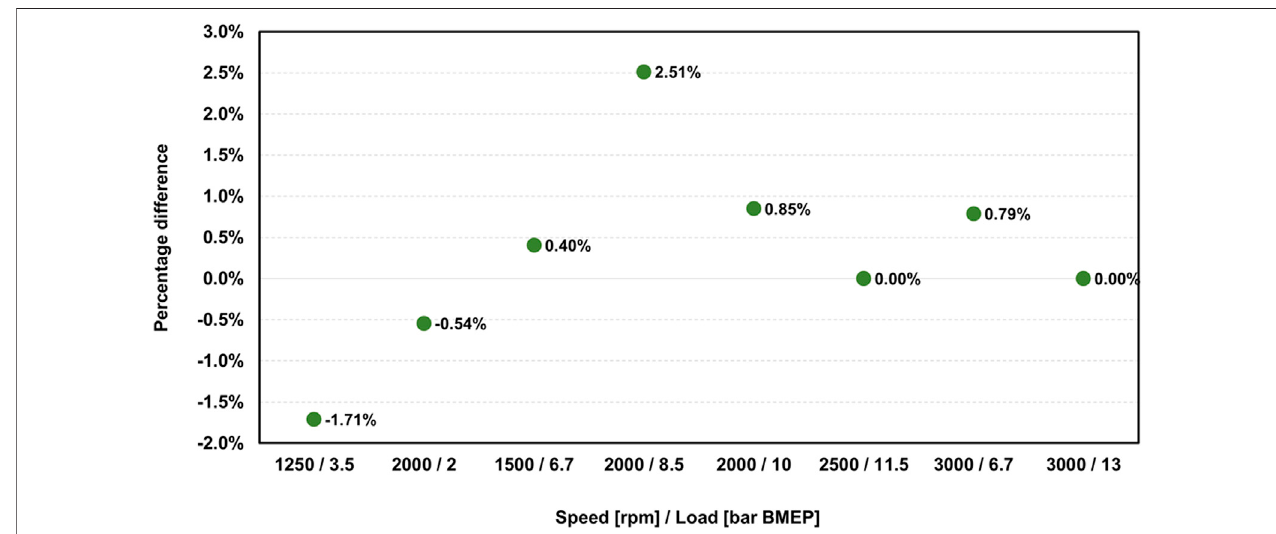
FIGURE 7 | BSFC Percentage difference between the baseline (stock) controller and SwRI controller.